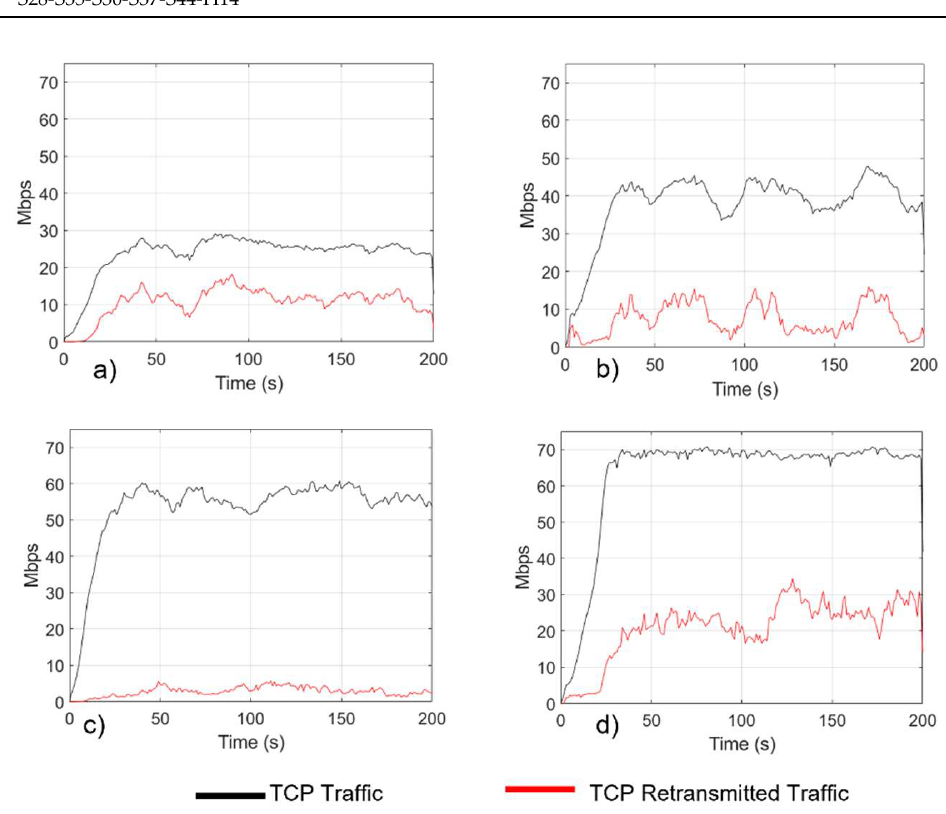
Figure 8. Evaluation of the path capacity using TCP traffic. The paths were selected according to the following methods: ( a ) H (hops), ( b ) B (bandwidth), ( c ) D (delay), and ( d ) PL (packet